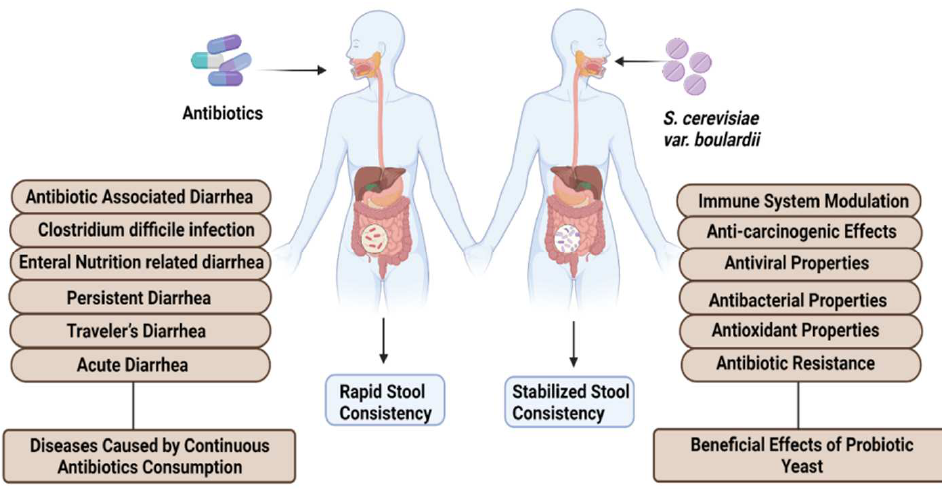
Figure 1. Health-promoting effects of S. cerevisiae var. boulardii.